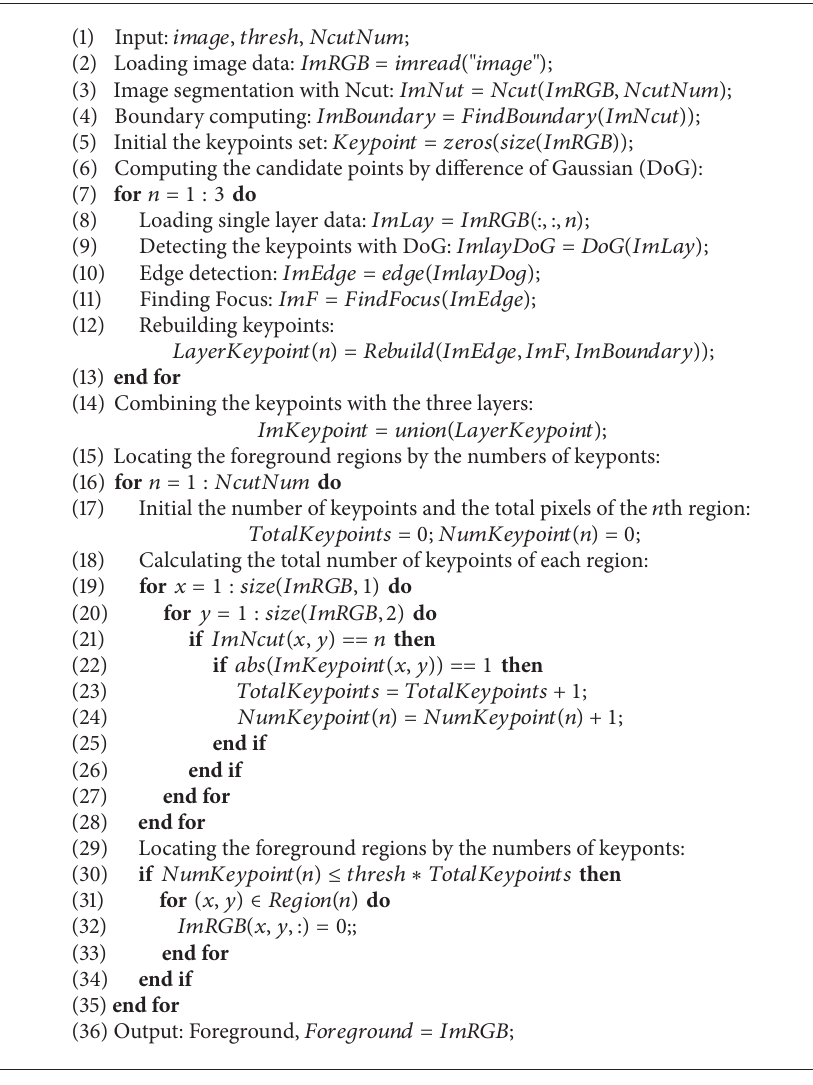
Algorithm 1: Extraction